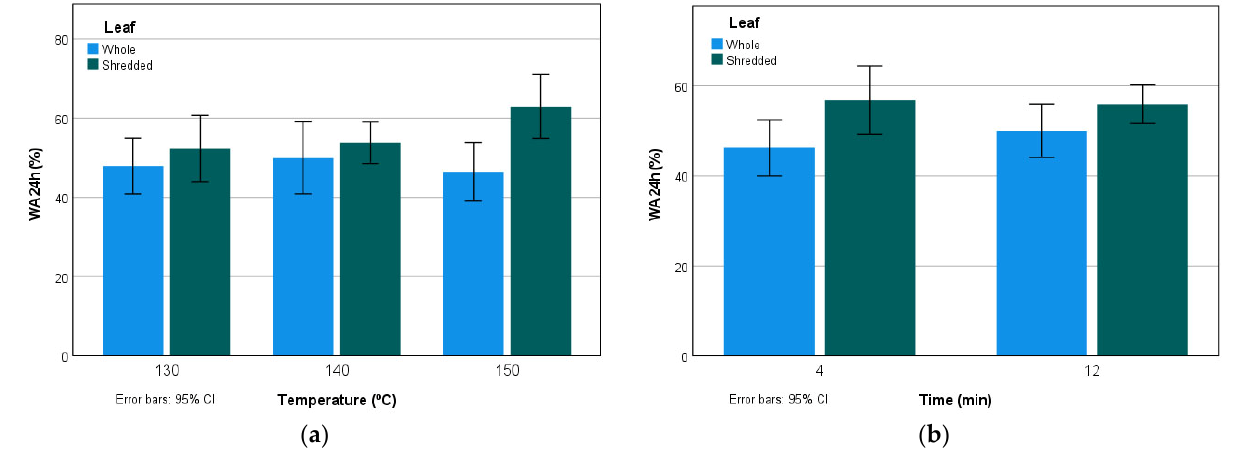
Figure 6. Water absorption (WA) after 24 h according to ( a ) temperature and ( b ) pressing time.